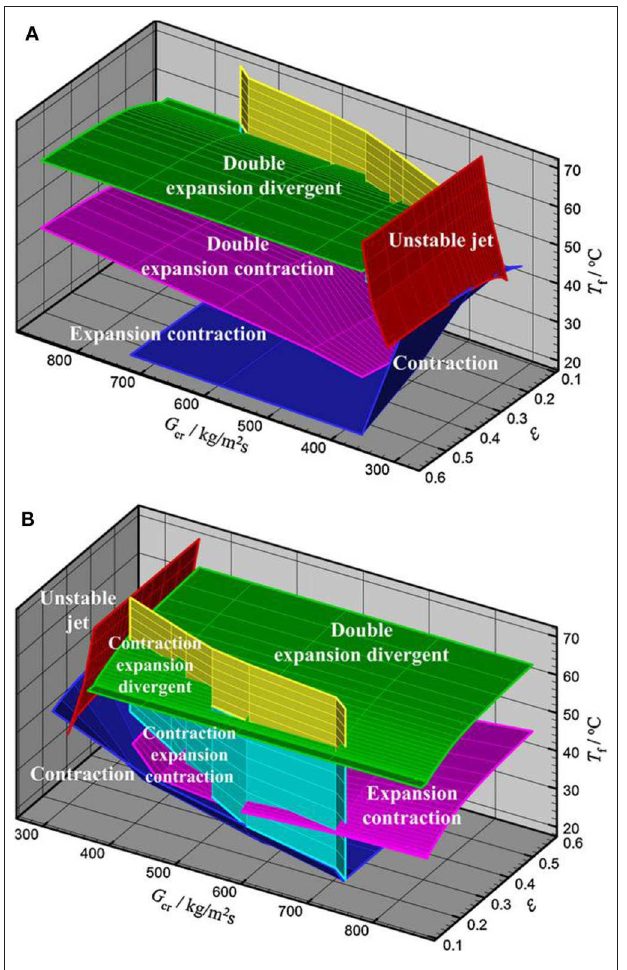
FIGURE 7 | The regime map developed by Wu et al. (2009a). (A) View from a side. (B) View from another side.